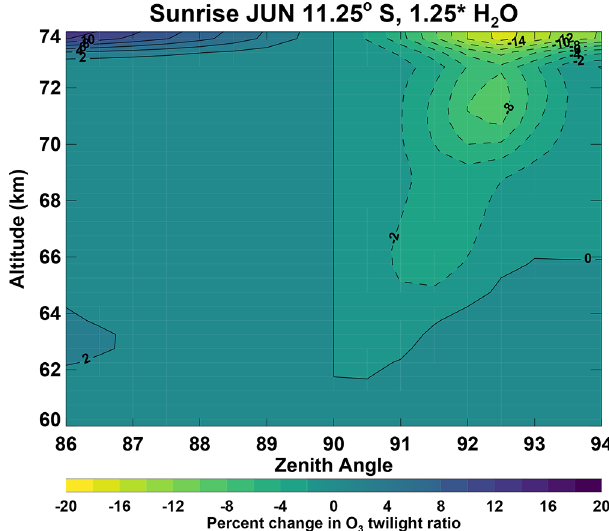
Figure 6. Percent change in the O 3 twilight ratio shown in Fig. 4 when the H 2 O in the diurnal model is increased by 25% at all alti- tudes. This figure corresponds to sunrise at 11.25 ◦ S in